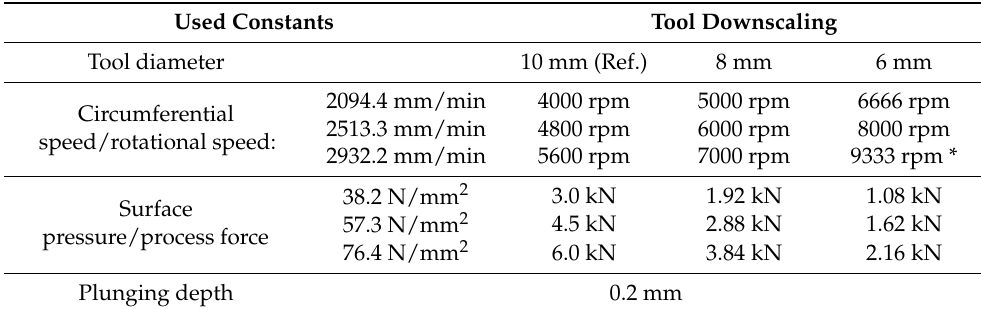
Table 1. Parameter matrix with three levels of circumferential speeds and surface pressures, which were held constant for all tools diameters and each corresponding respectively to a rotational speed and process force according to the tool scaling level. Used